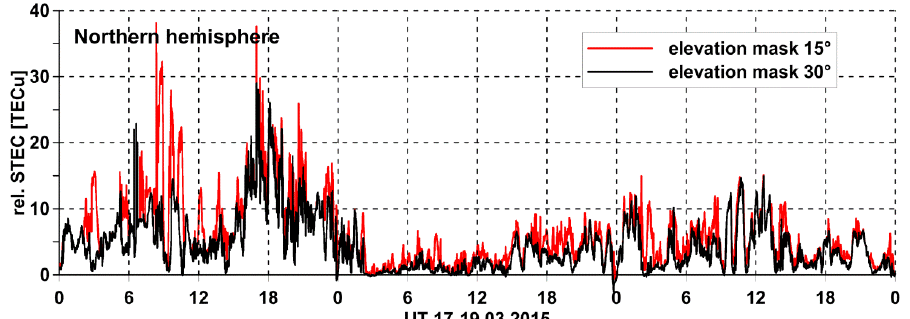
Figure 9. Variations of maximal relative STEC values according to the northern hemisphere sector given in Figure 7, as derived for two employed elevation cut-off angles.